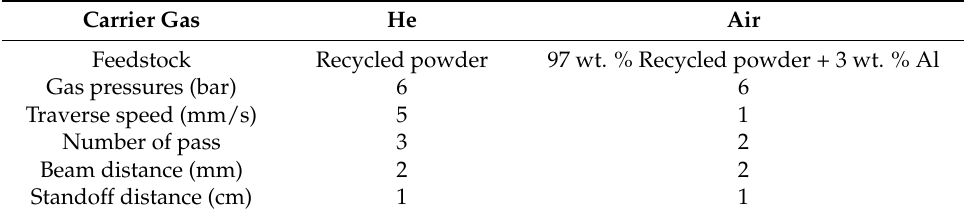
Table 2. Low-pressure coating parameters of cold spray process.